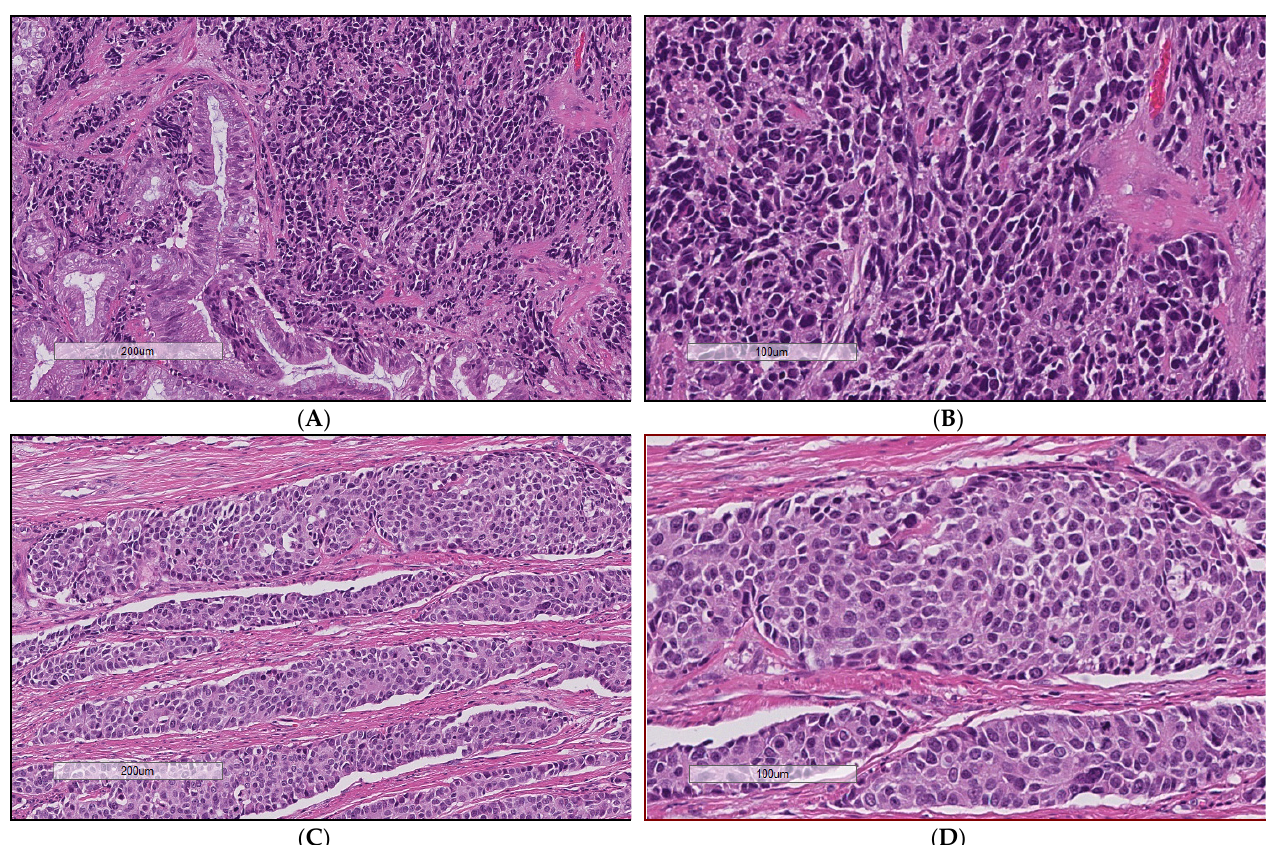
Figure 1. Examples of haematoxylin and eosin staining of extra-pulmonary neuroendocrine carcinomas. ( A , B ) Small-cell neuroendocrine carcinomas of the pancreas; sheets of packed tumour cells with fusiform nuclei and scant cytoplasm. ( C , D ) Large-cell neuroendocrine carcinomas of the colon; nests of polygonal tumour cells with prominent nucleoli and more abundant cytoplasm compared to their small-cell counterpart. Table 1. Clinico-pathological characteristics of patients with extra-pulmonary neuroendocrine car- cinomas included in this study.